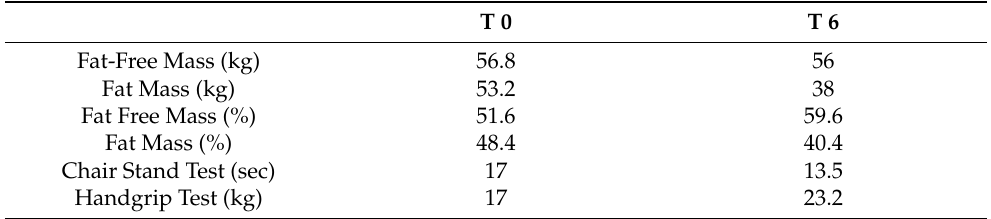
Figure 2. Physical performance measured by the handgrip strength test and chair stand test at the beginning (T0) and at the end (T6) of VLCKD+IT.4. Discussion. In this brief case report, we analyzed the effects of a 6-week VLCKD, combined with a physical exercise program, in a middle-aged woman affected by SO and dyslipidemia. As observed in a previous study, the VLCKD was effective as a dietary approach, de- termining a reduction in BW and fat mass, and skeletal muscle maintenance [26]. In general, skeletal muscle loss may occur, along with BW reduction, during a hypocaloric diet [27], and an increase in muscle proteolysis has been suggested to play a role in mus- cle mass reduction under calorie restriction [27]. Amino acid availability affects muscle proteolysis and protein synthesis, and diets designed for weight loss which have a high protein content have been shown to preserve lean mass [28,29]. Interestingly, supplementation with whey protein and leucine has been shown to maintain skeletal muscle mass in subjects with obesity following a hypocaloric diet and a resistance training program [30]. In general, VLCKD provides a total daily protein in- take of 1.2 g (female) or 1.5 g (male) per kg of BW, which is expected to preserve muscle during weight loss. Accordingly, the present case report indicates that a VLCKD was able